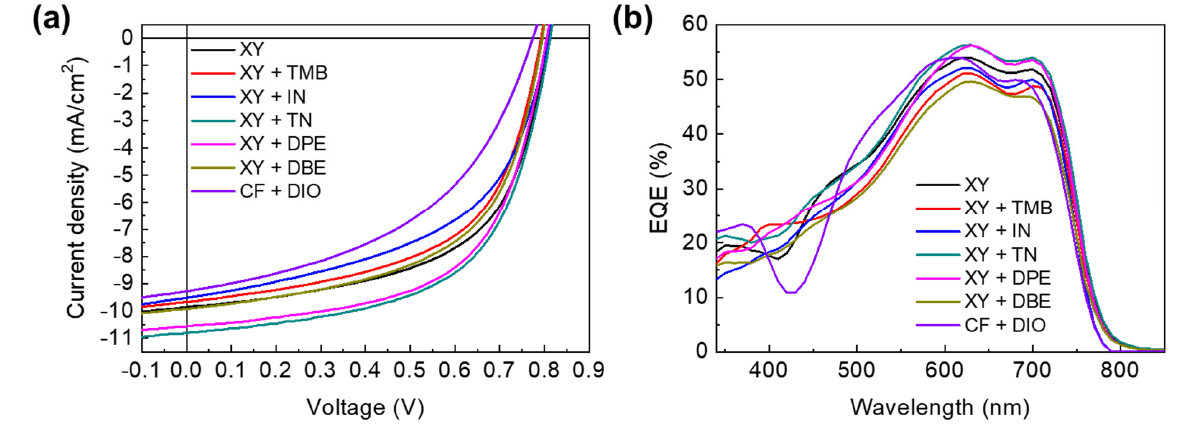
Figure 2. ( a ) J − V curves and ( b ) EQE spectra of APSCs based on XY and XY + additives. The results from the CF + DIO solvent system are included for comparison. Table 1. Photovoltaic parameters of APSCs prepared from XY, XY + additives, and CF + DIO solutions .